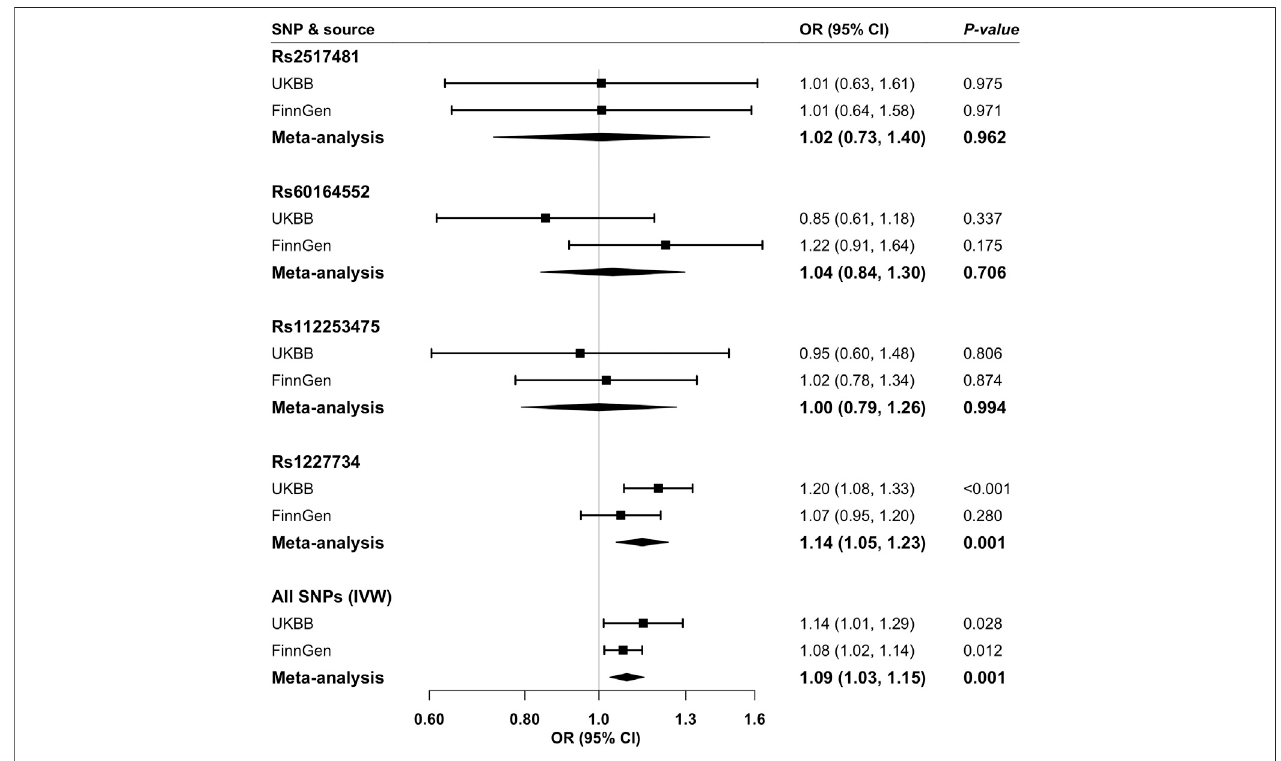
FIGURE 2 | Association of genetically predicted growth differentiation factor 15 levels with gallstone disease risk in Mendelian randomization analysis. CI, con fi dence interval; IVW, inverse variance weighted; OR, odds ratio; SNPs, single nucleotide polymorphisms; UKBB, UK Biobank. Estimates of analyses based on all SNPs were derived from the random-effects inverse-variance weighted